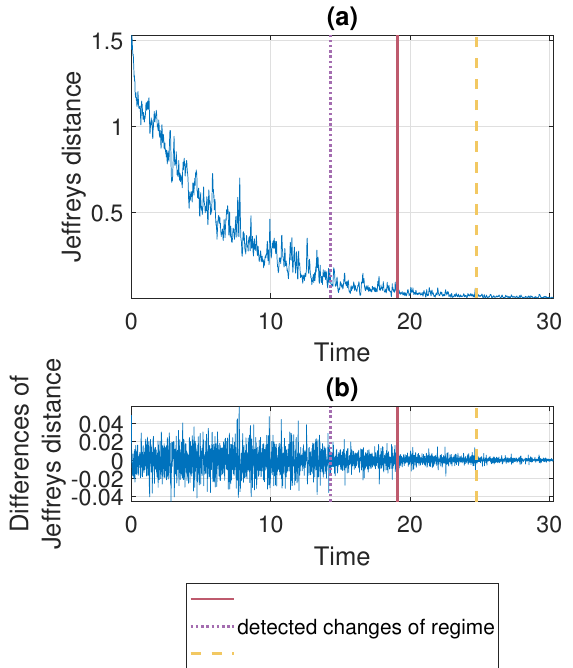
Figure 8. Jeffreys distance (panel ( a )) and differences of Jeffreys distance (panel ( b )) comparing the pdfs in the moving window of length 2500 with step equal to 250 to the the pdf corresponding to the last window for Signal 2. Detected regime change points are marked in purple (dotted line), red (solid line) and yellow (dashed